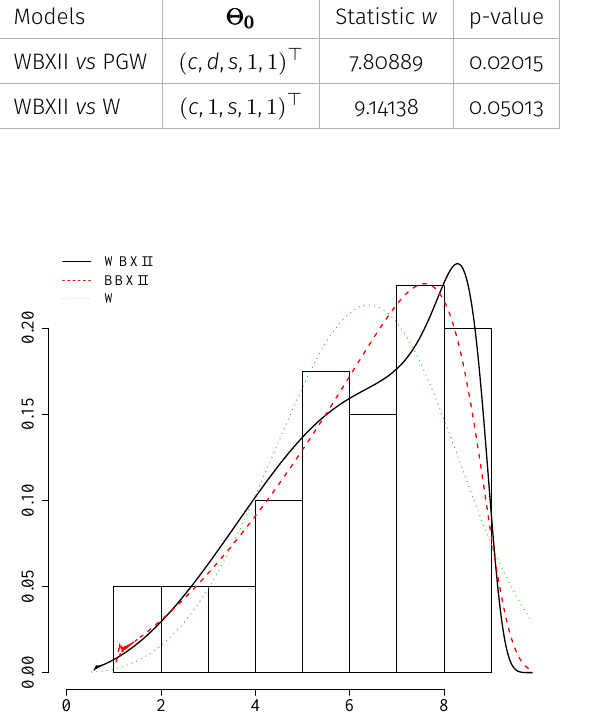
Table VII. LR statistics for the fits to the turbochargers failure time data. Models